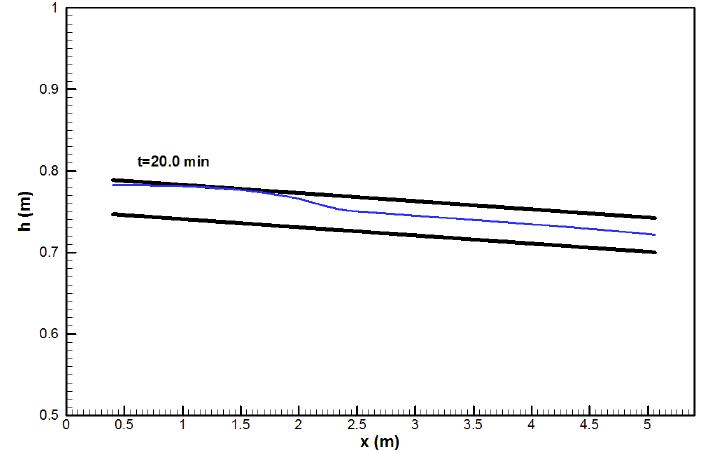
Figure 17. Conduit C2 (black lines) and the hydraulic head h (m) (blue line) at t = 20.0